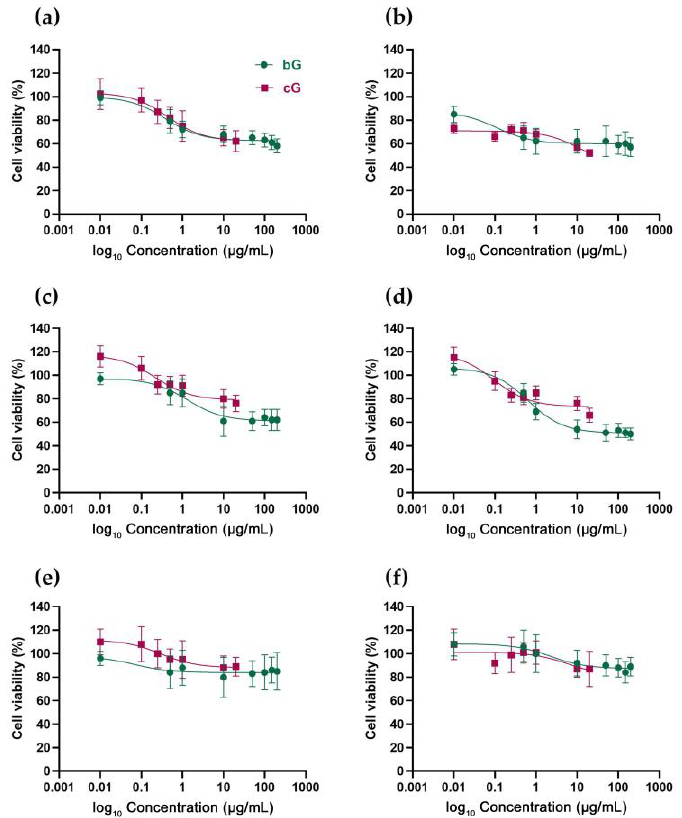
Figure 3. Cell viability of NIH/3T3 ( a , b ), HaCaT ( c , d ) and THP-1 cells ( e , f ) after treatment with bG and cG for 24 ( a , c , e ) and 48 h ( b , d , f ). and cG for 24 ( a , c , e ) and 48 h ( b , d , f